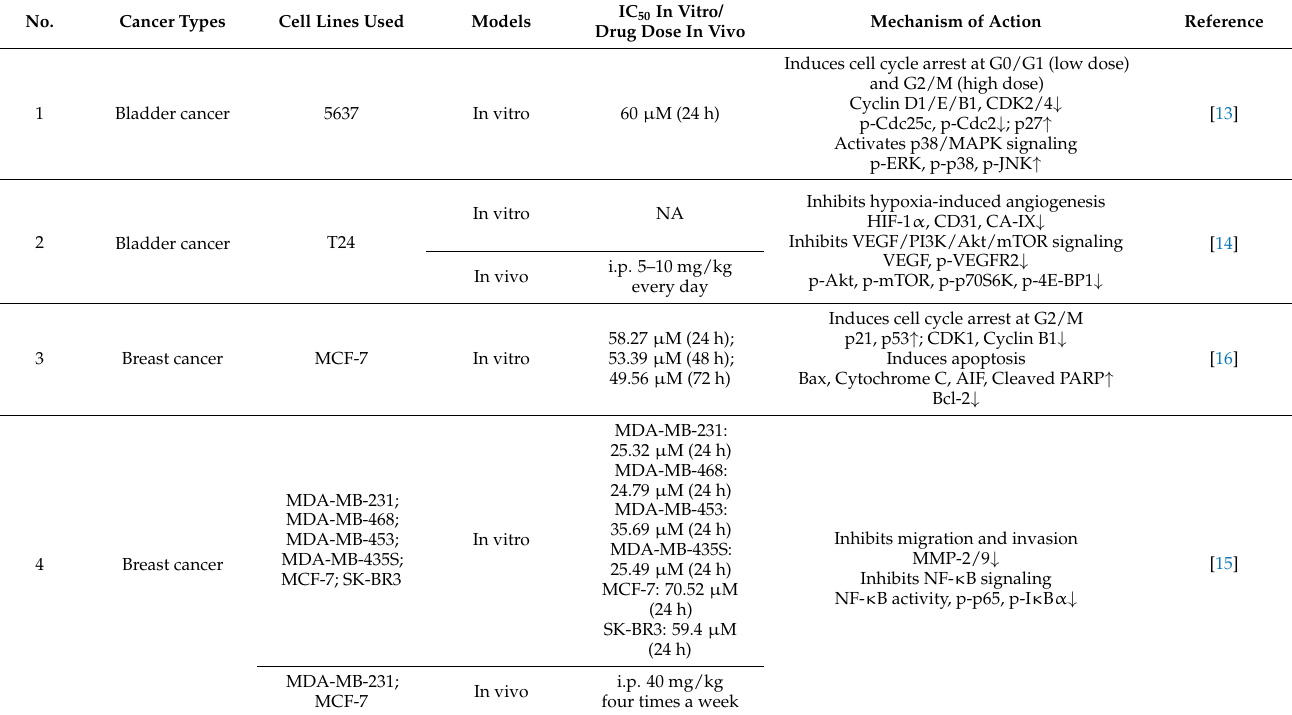
Table 1. The anticancer effect of magnolol against various cancer